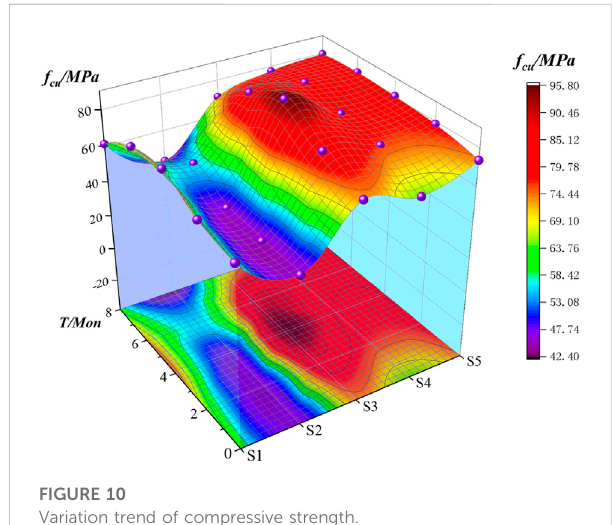
FIGURE 10 Variation trend of compressive strength.